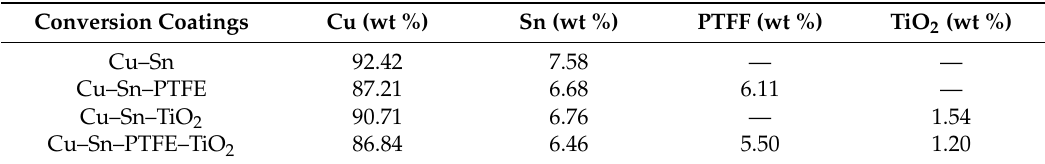
Table 3. The compositions of the coatings.